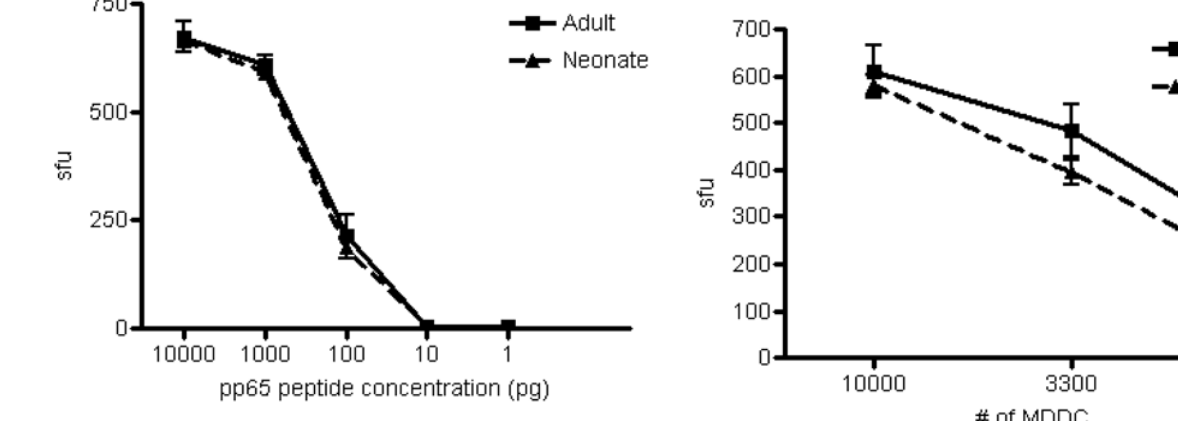
Figure 3. DC from adult and neonatal blood are similar in their ability to process and directly present the HLA-A2 restricted antigen HCMV pp65 epitope NVLPMVATV following recombinant vaccinia infection. HLA-A2 + DC from adults ( n= 11) and neonates ( n= 7) were infected with vvpp65 (moi=1.5) overnight. Infected and uninfected DC were titrated over a range (10,000 to 1,100 cells/well) and incubated overnight with pp65-specific CD8 + T cell clone D2-1-D2 (10,000 cells/ well). IFN- c production was detected by ELISPOT. HLA-A2 2 DC from both adults and neonates did not induce any IFN- c production by CD8 + T cell clone D2-1-D2. There was no statistically significant difference between adult and neonatal DC in processing and directly presenting antigen following recombinant vaccinia infection (p=0.6489).